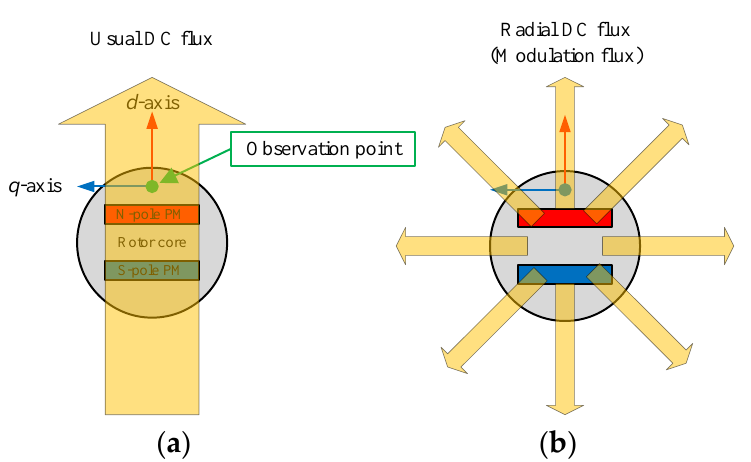
Figure 4. DC flux in rotor: ( a ) usual DC flux; ( b ) radial DC flux.